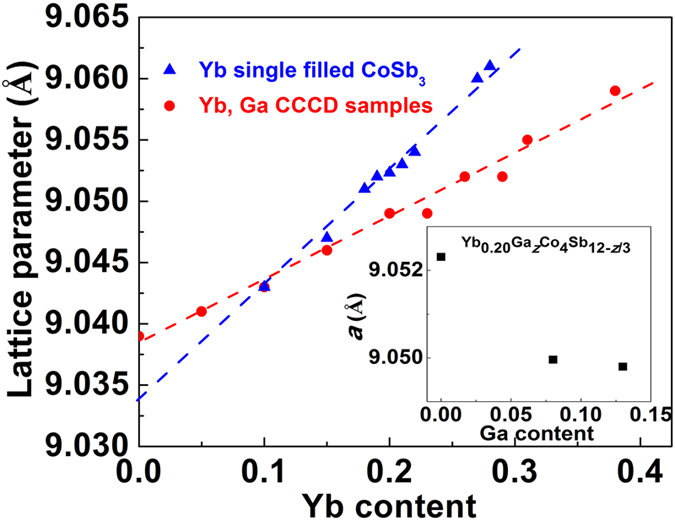
Lattice parameter (a) as a function of Yb content.Blue triangles are Yb single filled Co4Sb12 and red circles represent Yb, Ga CCCD samples: YbxGa0.2Co4Sb11.9333 (x = 0, 0.05, 0.10, 0.15, 0.20, 0.26) and YbyGa0.15Co4Sb11.95 (y = 0.25, 0.30, 0.35, 0.40). The data of Yb single filled Co4Sb12 are from this study and taken from the literatures467. The dashed lines are the trend for eye guidance. The inserted figure plots the lattice parameters of Yb0.20GazCo4Sb12-z/3 (z = 0, 0.10, 0.15) as a function of Ga content.